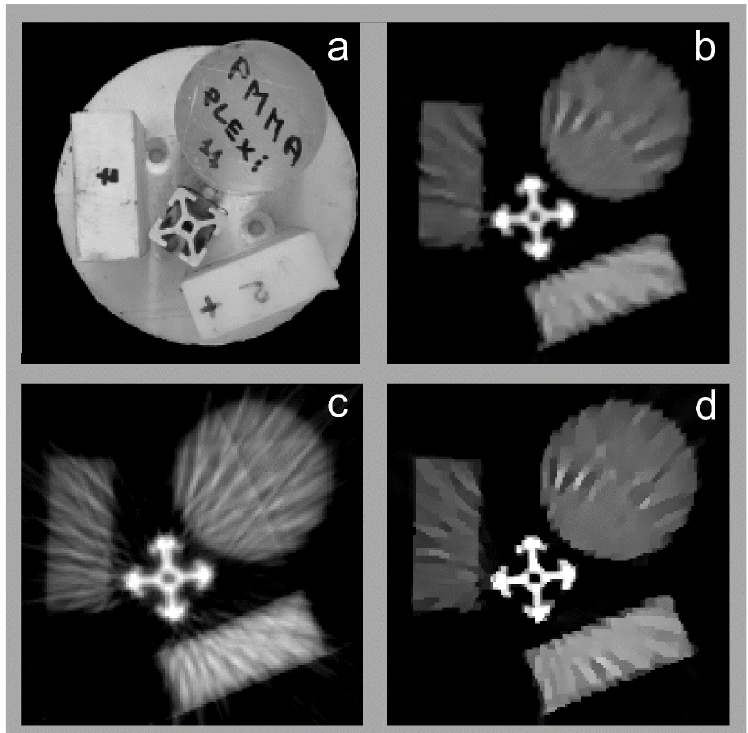
Figure 4. The sample object ( a ), as well as its reconstructed CT image using present work algorithm ( b ), as well as the Jumanzarov et al. [22] ( c ) and van Aarle et al. [35] ones ( d